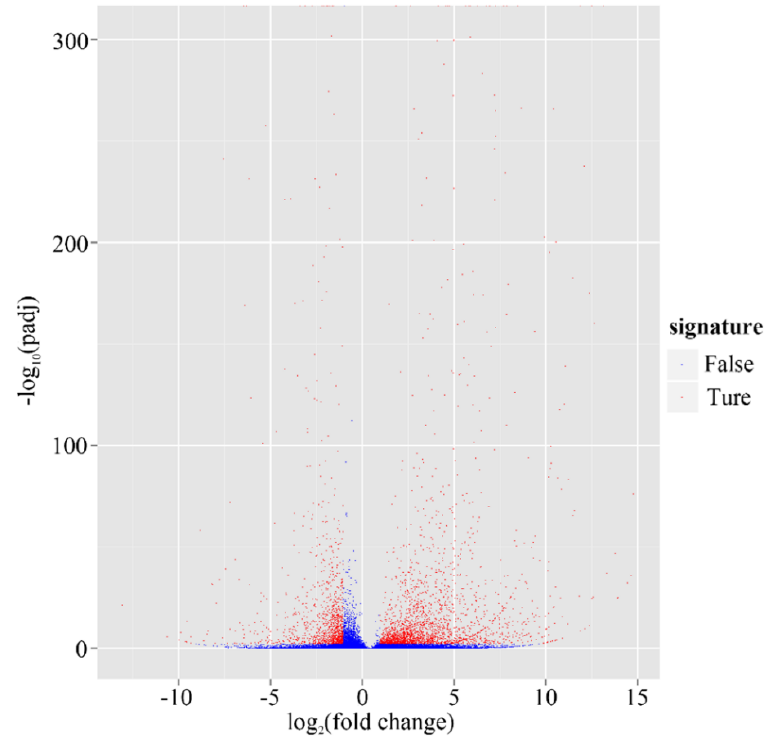
Figure 7. Volcano plot of Leaf ves. Root in G. rigescens . The abscissa represents changes of gene expression (Leaf vs. Root). The ordinate represents the statistical significance of change of the amount of gene expression. The less p -value, the more −log 10 ( p value), and the more significance. The scattering dots represent genes, while the blue dots show genes without significant differences and vice versa for red